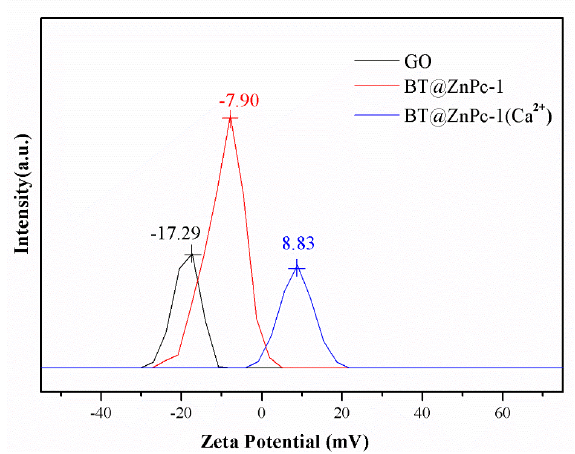
Figure 3. Intensity of light-scattering versus zeta potential (calculated based on applied voltage) in electrophoresis through suspension of charged particles at pH = 7.